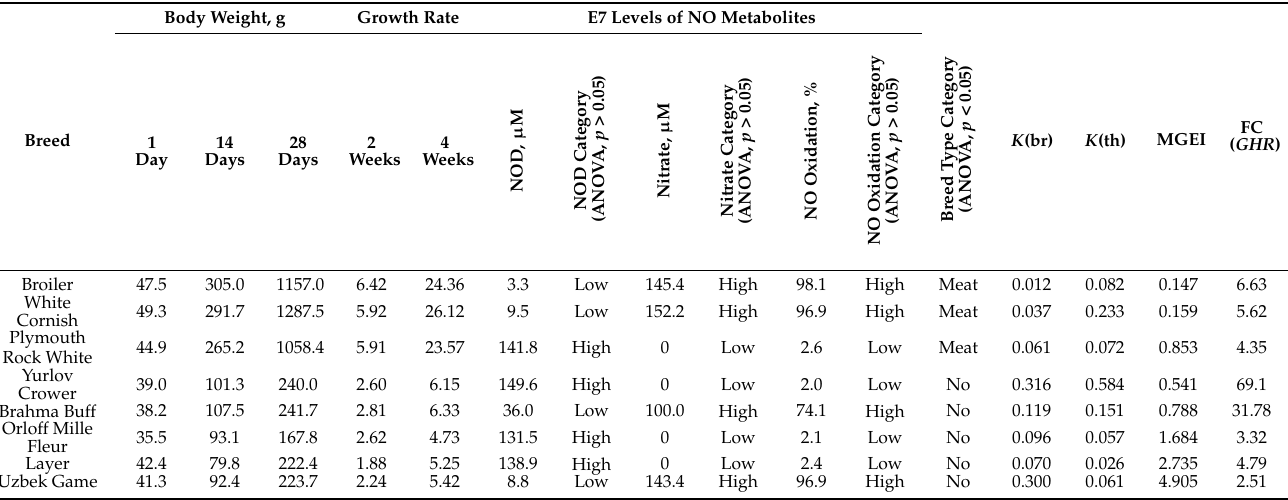
Table 3. Breed scores for phenotypic/metabolic traits and K * coefficients in the breast ( K (br)) and thigh ( K (th))